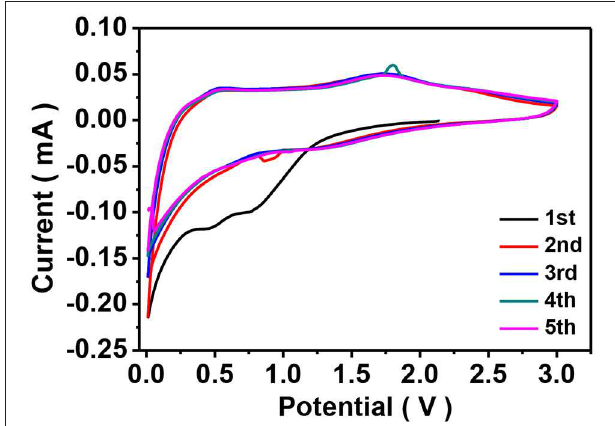
FIGURE 7 | CV curves of the ZIF-67-C@MoS 2 composite as PIB anodes at the scan rate of 0.1mV s − 1 .